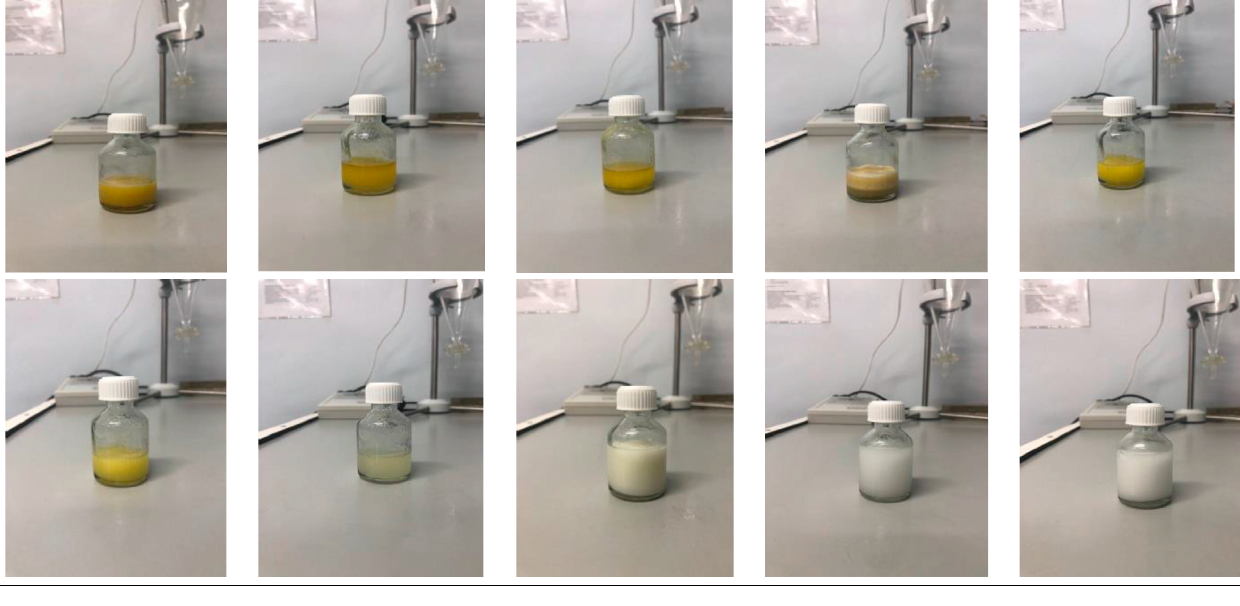
Table 3: Figures of model mixtures of emulsion-type eye drop based on the SP Model no. 1